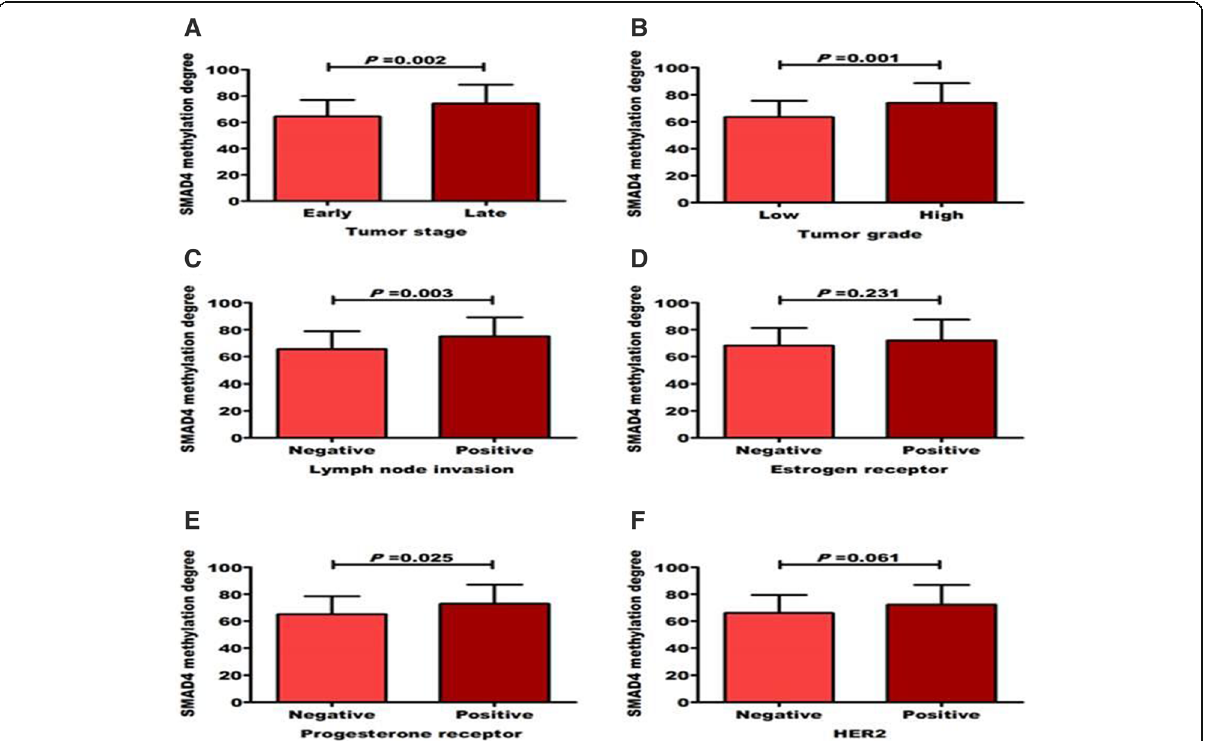
Fig. 4 Distribution of SMAD4 methylation degree among breast cancer patients according to tumor ( a ) stages, ( b ) grades, ( c ) lymph node, ( d ) estrogen receptor, e progesterone receptor, and ( f ) HER2 statuses. Significant difference was determined using Student ’ s t test. P value < 0.05 was considered significant